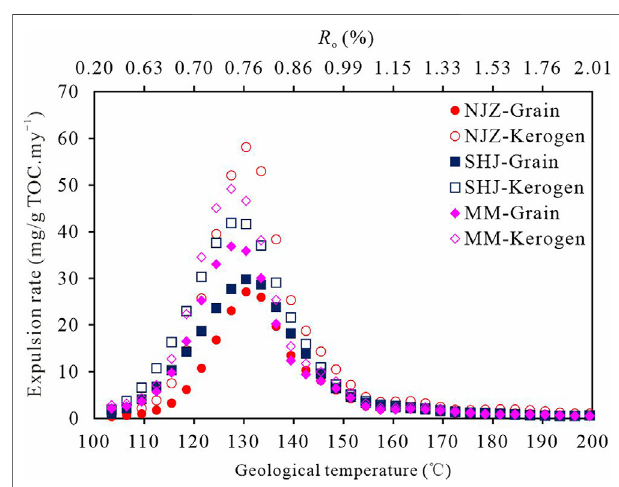
FIGURE9| Expulsionratesforthreesamplesatageologicalheatingrate of 3 °